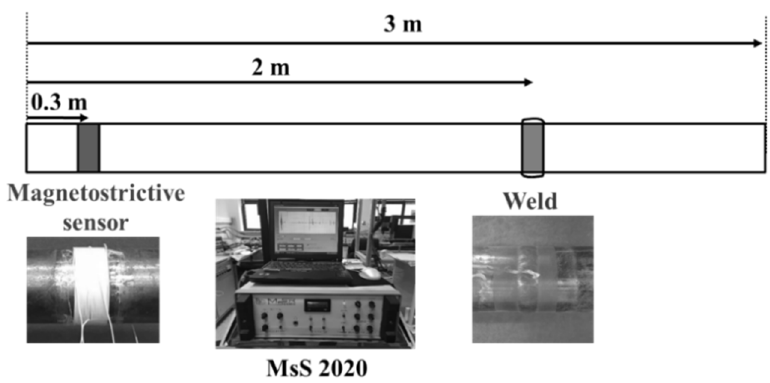
Figure 5. The schematic diagram of the magnetostractive wave guide ultrasonic monitoring system.